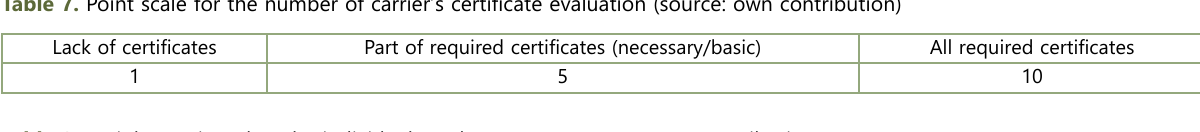
Table 8. Weights assigned to the individual product groups (source: own contribution) Criterion